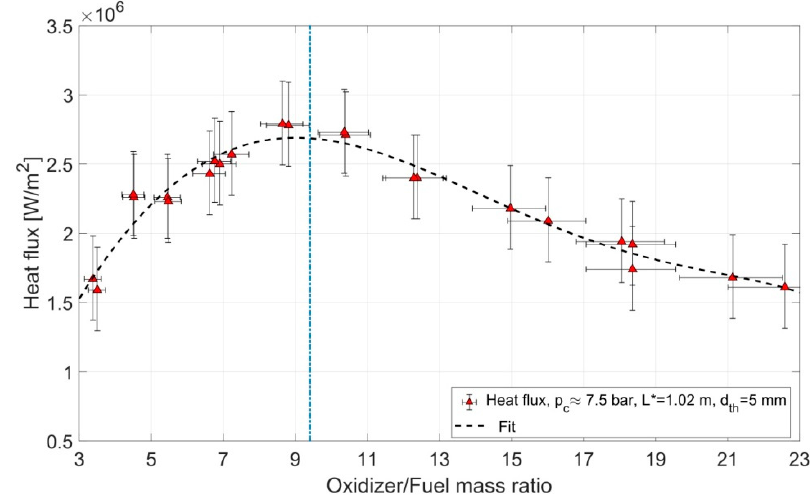
Figure 20. Measured heat flux to combustion chamber walls depending on oxidizer to fuel mass flow ratio o / f . The o / f of a stoichiometric mixture is 9.41, the chamber pressure was 7.5 bar, the nozzle throat diameter 5 mm and the characteristic chamber length L * 1.02 m.